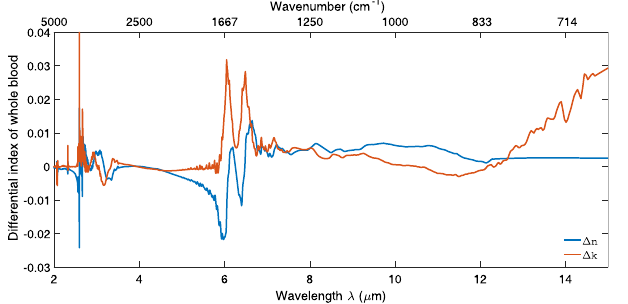
Figure 6. Change in the real and imaginary parts of refractive index for whole blood with respect to